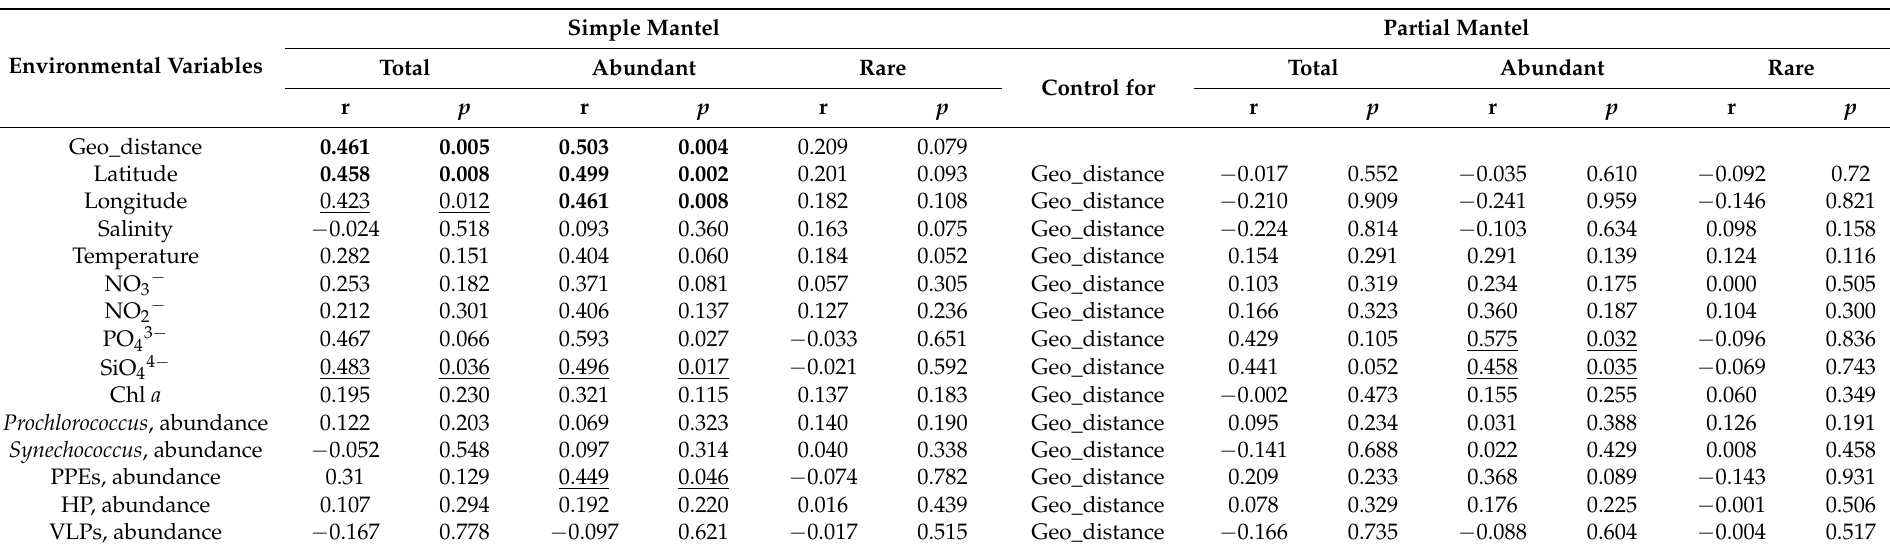
Table 4. Simple and partial Mantel tests for the correlations between environmental variables and community composition in the surface water. When the correlation is significant both r- and p -values are underlined ( p < 0.05) or in bold ( p < 0.01). (Geo_distance, geographic distance; HP: Heterotrophic prokaryotes; PPEs, pigmented pico-sized eukaryotes; VLPs, viral like